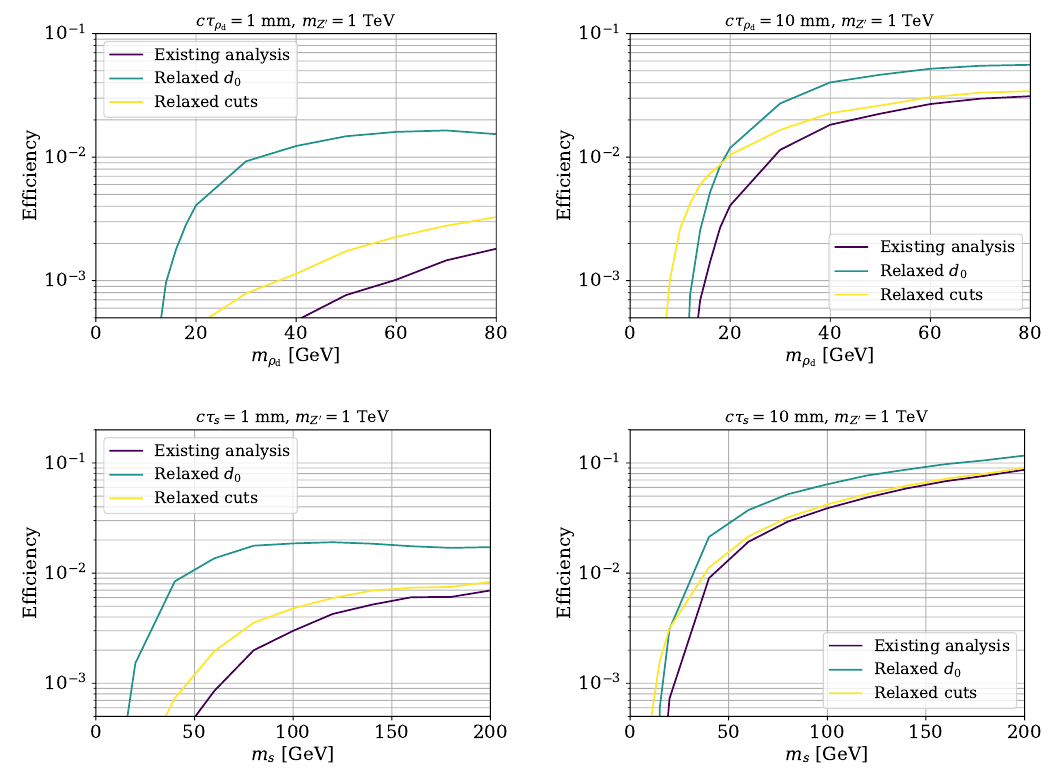
Figure 6 . Efficiencies for the dark shower model (top) and the dark Higgs model (bottom) as a function of the LLP mass for the existing analysis, compared to the two proposed relaxations. The LLP lifetime is fixed to 1 mm (left) and 10 mm